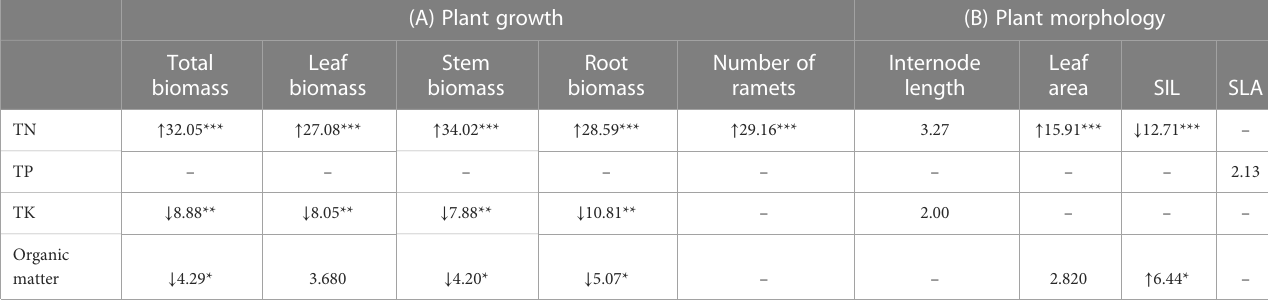
F- and P-values were obtained from stepwise multiple liner regressions with backward selection procedure. Signi fi cance of relationships: ***P < 0.001, **P < 0.01 and *P < 0.05. “ - ” indicates variables that were not included in the fi nal model. “ ↑ ” and “ ↓ ” indicate positive and negative relationships, respectively.